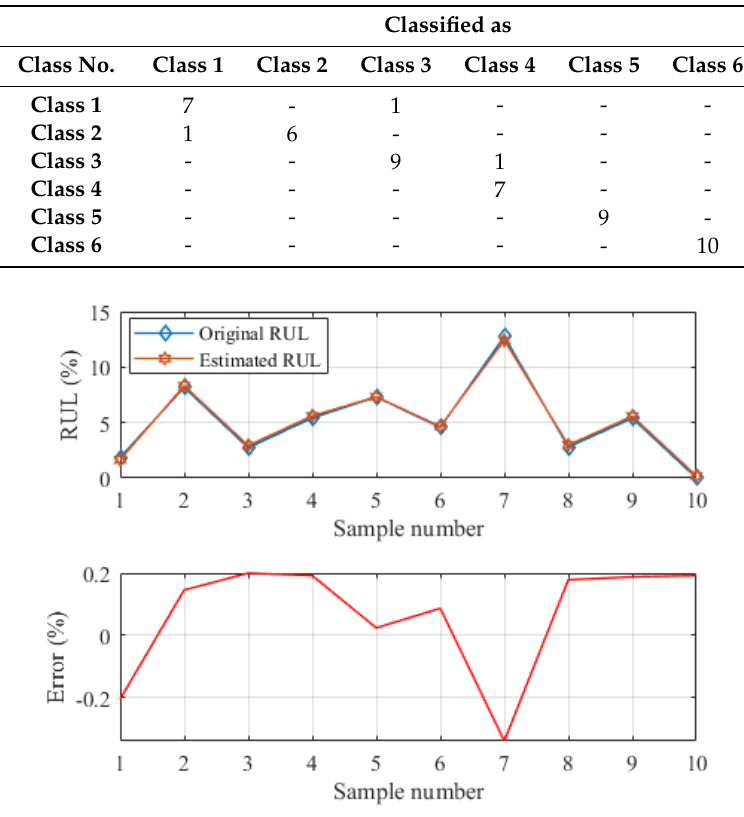
Figure 5. Prediction of RUL using features of full discharge data.